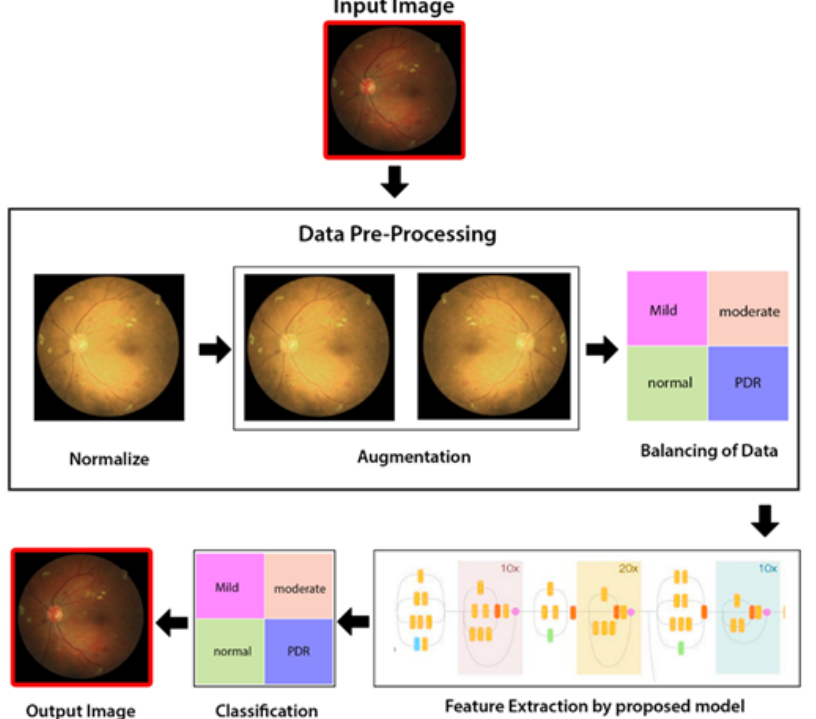
Figure 4. Proposed methodology diagram flow.